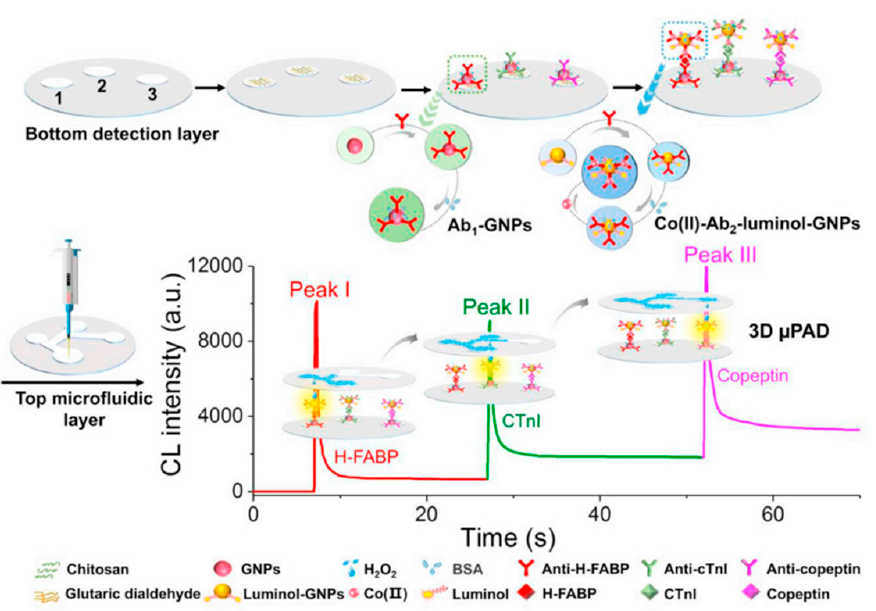
Figure 8. Schematic of 3D µ PAD with three detection zone for multiple immunoassays of H-FABP, cTnI, and copeptin. Reprinted with permission from [146]. Copyright 2020 Elsevier.